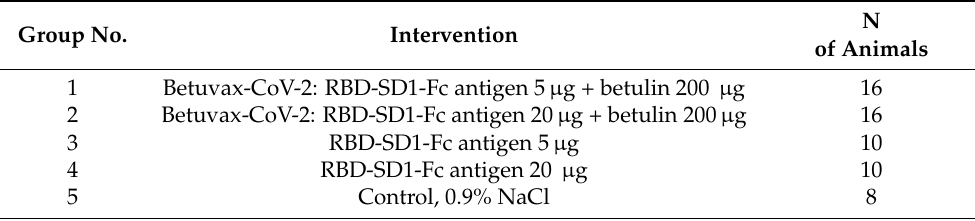
Table 1. The description of animal groups in the humoral immune response study. Group